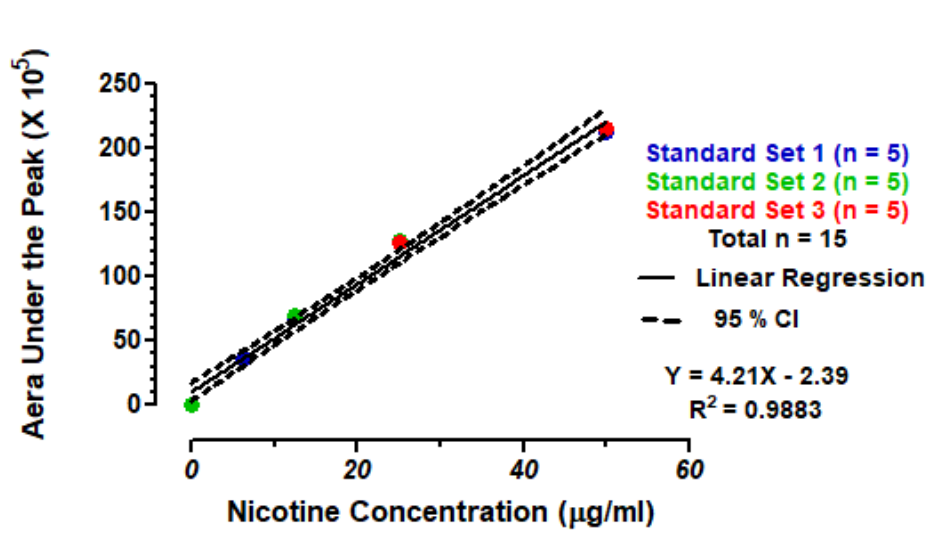
Figure 3. Nicotine calibration curves.